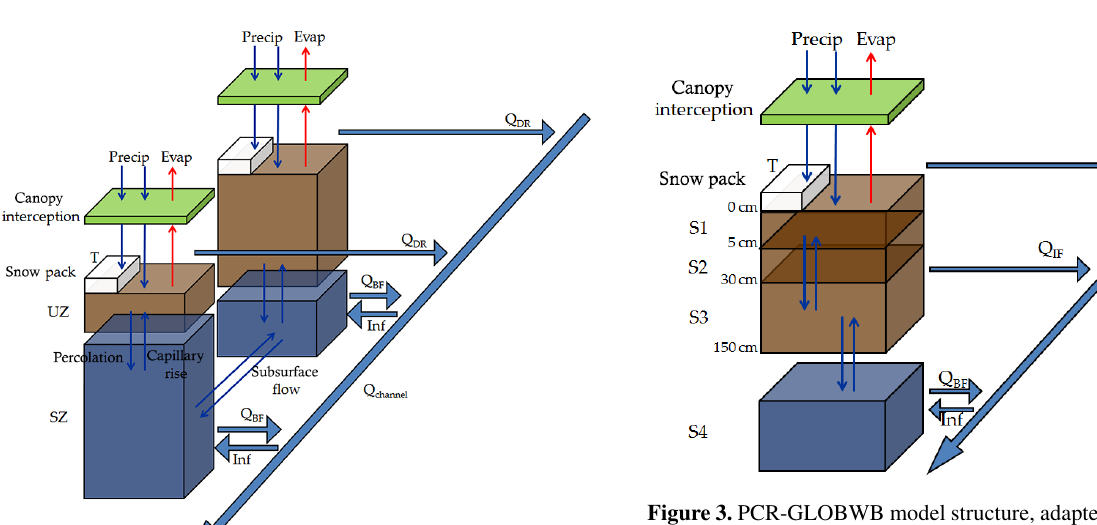
Figure 3. PCR-GLOBWB model structure, adapted from Van Beek et al. (2011). Symbols’ definitions are as follows: Precip, pre- cipitation; Evap, evaporation; T , temperature; S1, first soil layer; S2, second soil layer; S3, third soil layer; S4, groundwater reser- voir; Qchannel, total runoff; QDR, direct runoff; QIF, intermediate flow; QBF, baseflow; and Inf, water flow from the river channel to the groundwater